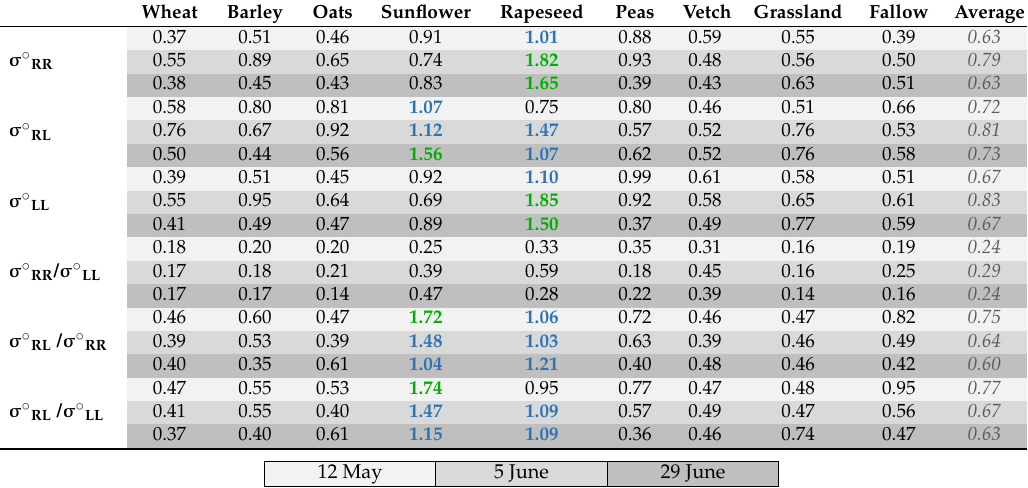
Table 2. Average JM distance for each studied crop and date as well as the average of all crop pairs, for σ ˝ RR , σ ˝ RL , σ ˝ LL , and their ratios. Colors and shades as in Table 1. Wheat Barley Oats Sunflower Rapeseed Peas Vetch Grassland Fallow